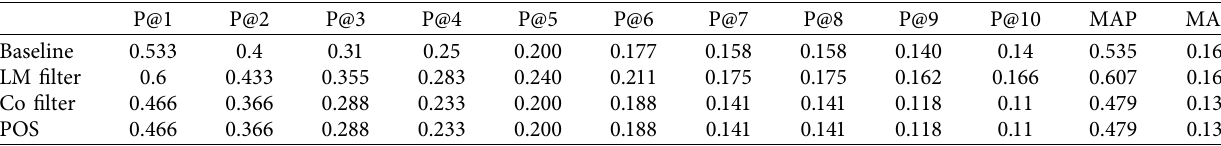
Table 14: Results of using the SynoExtractor pipeline on Gigaword embeddings.